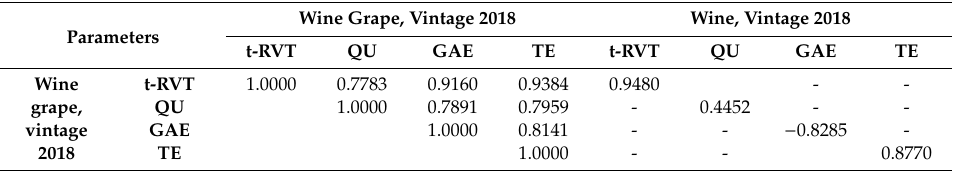
Table 4. Correlation matrix of antioxidant parameters of red wine grapes and corresponding wines, vintage